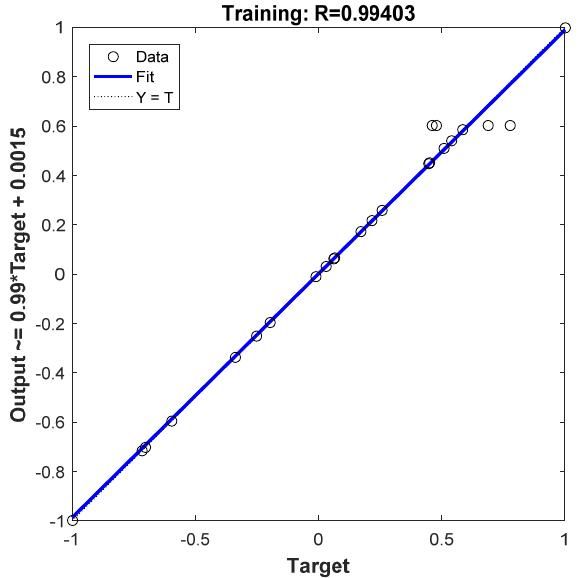
Figure 18. Training process of BP-ANN.